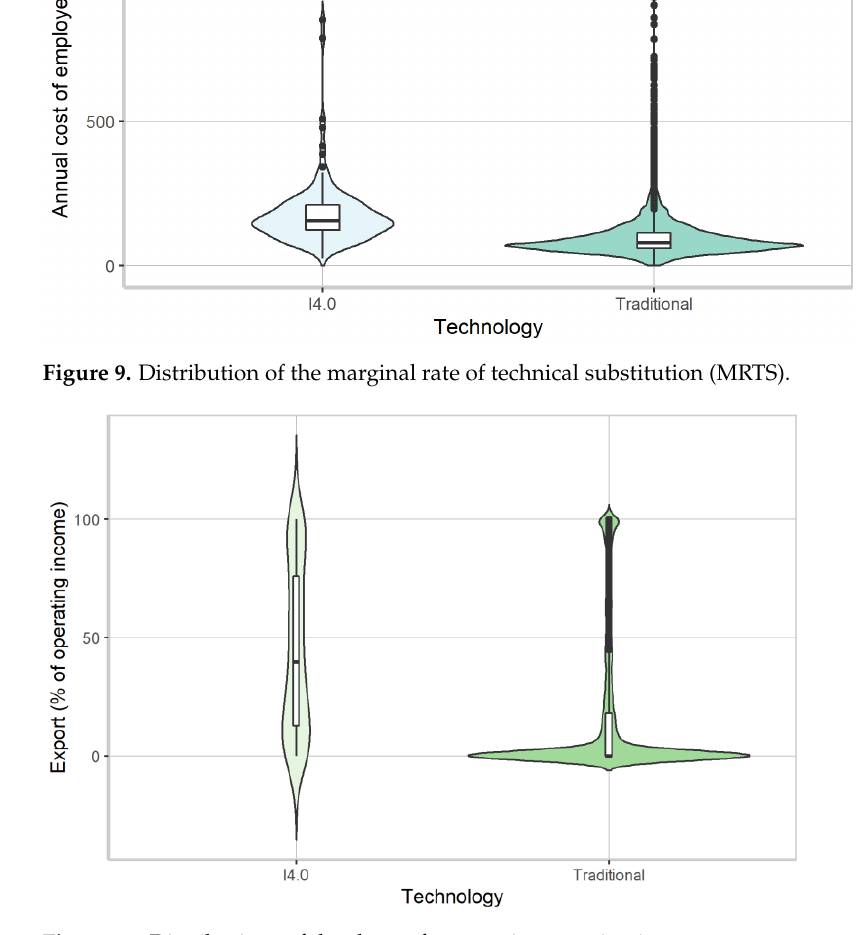
Figure 10. Distributions of the share of exports in operating income. Figure 10 . Distributions of the share of exports in operating income . Table 7 . ANOVA of the share of exports in operating income . Table 7. ANOVA of the share of exports in operating